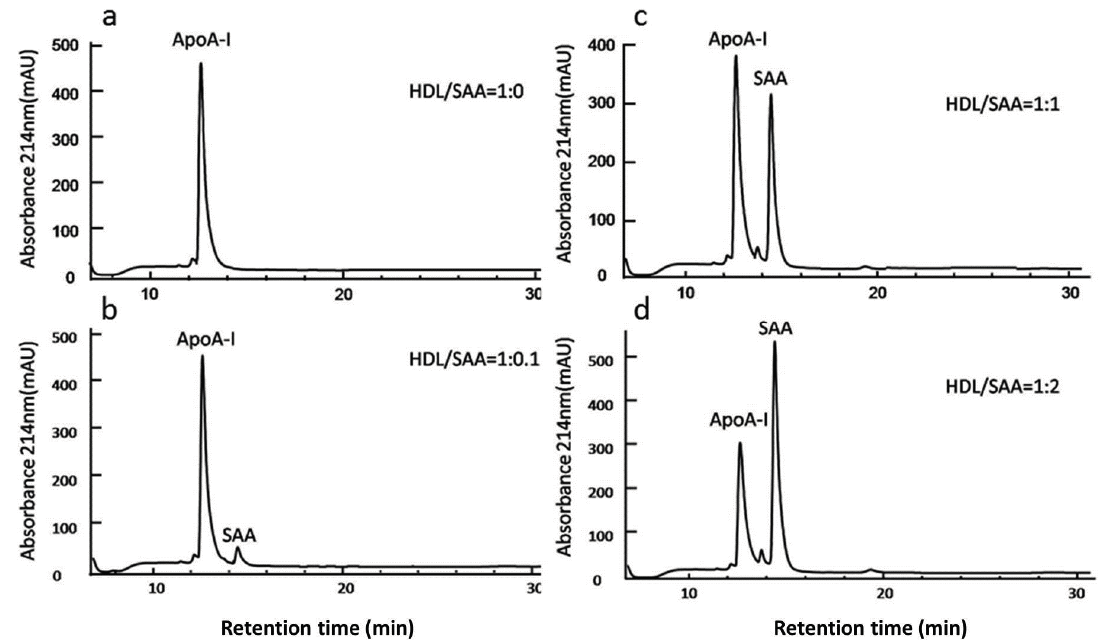
Figure 5. SAA displaces ApoA-I causing remodelling of the apolipoprotein profile of HDL. Freshly isolated HDL (250 μ g/mL) was treated with vehicle (control) or SAA (at the final ratio indicated), and then dialysed against PBS to remove any free SAA. Proteins were then separated by reversed-phase chromatography using a linear acetonitrile gradient and monitoring at A 214 nm . Chromatograms show altered HDL protein composition after exposure to SAA at ratios of HDL/SAA corresponding to: ( a ) 1:0; ( b ) 1:0.1; ( c ) 1:1 and ( d ) 1:2 mol/mol. Proteins (ApoA-I ~13 min) and SAA (~14.5 min) each eluted as a single symmetric peak.